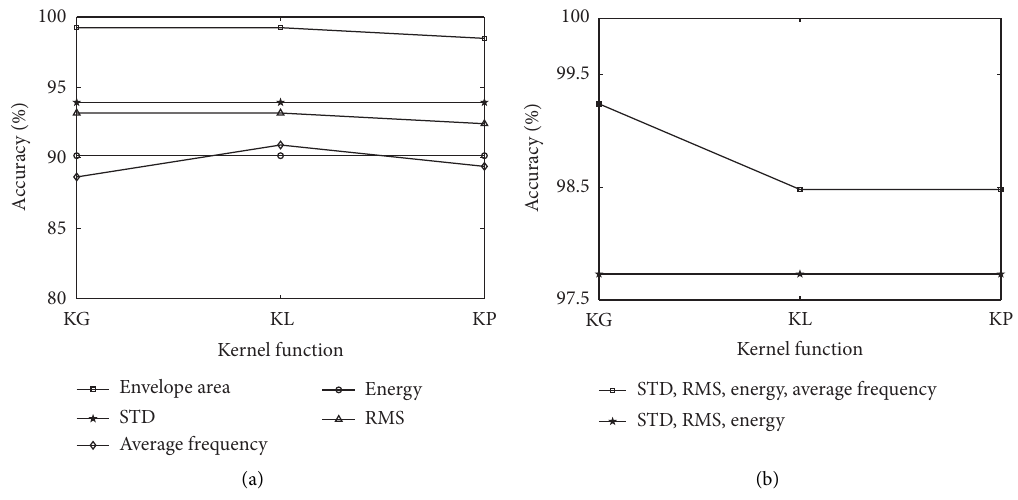
Figure 6: The validation results for kernel function and features: (a) qualified features; (b) feature sets. Table 3: Validation results for unqualified features based on 3 kernel